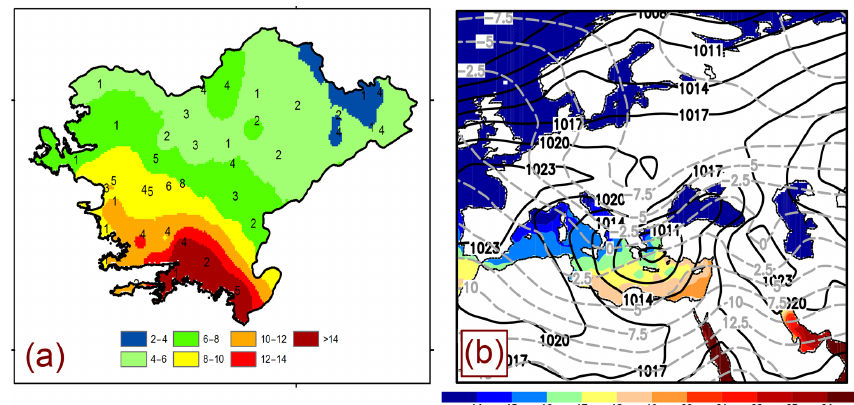
Figure 8. (a) Daily mean precipitation values of cyclonic precipitation types (mm, shaded) and the counts of EP days of the Aegean stations for the winter months during 2006–2015. (b) Composites of the daily mean sea level pressure (MSLP, solid lines), sea surface temperature (SST, shaded), and air temperature at 850hPa (dashed lines) for the average of 35 extreme precipitation days over the